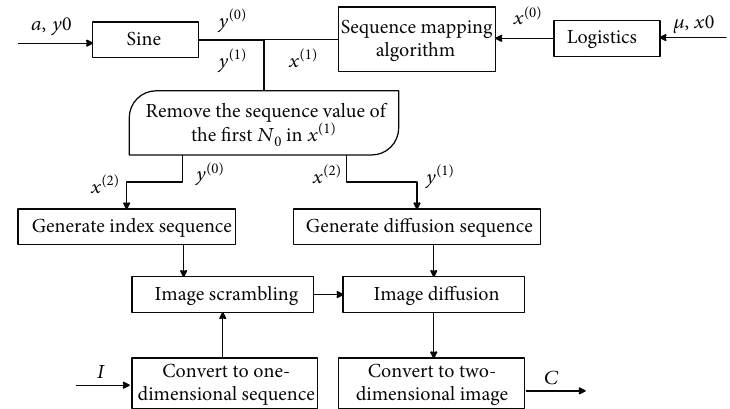
Figure 3: Block diagram of chaotic encryption algorithm of the original image.